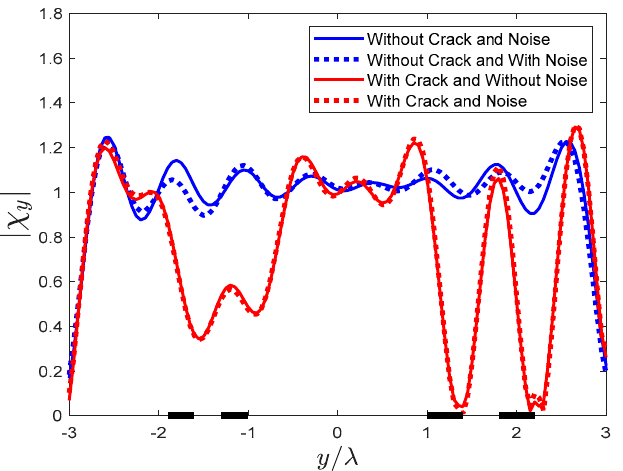
Figure 15. The reconstruction of the contrast function on the left side of the square in the presence of noise. The bold black lines indicate the position of the cracks.